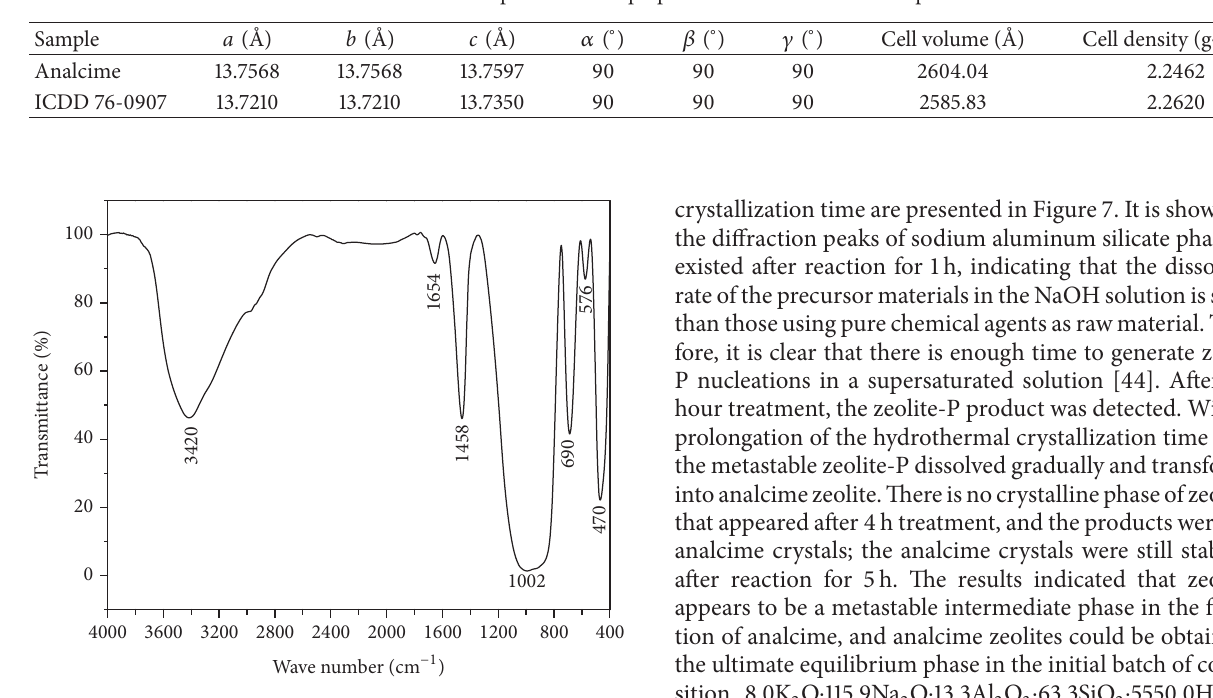
Figure 6: FT-IR spectrum of ANA zeolite synthesized in 0.5 mol/L NaOH solutions at the crystallization temperature of 175 ∘ C for